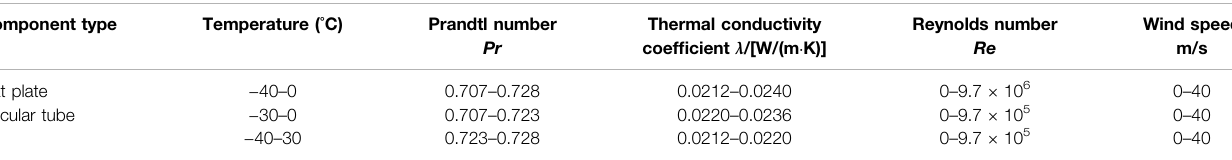
TABLE 3 | Constants in the heat transfer calculation